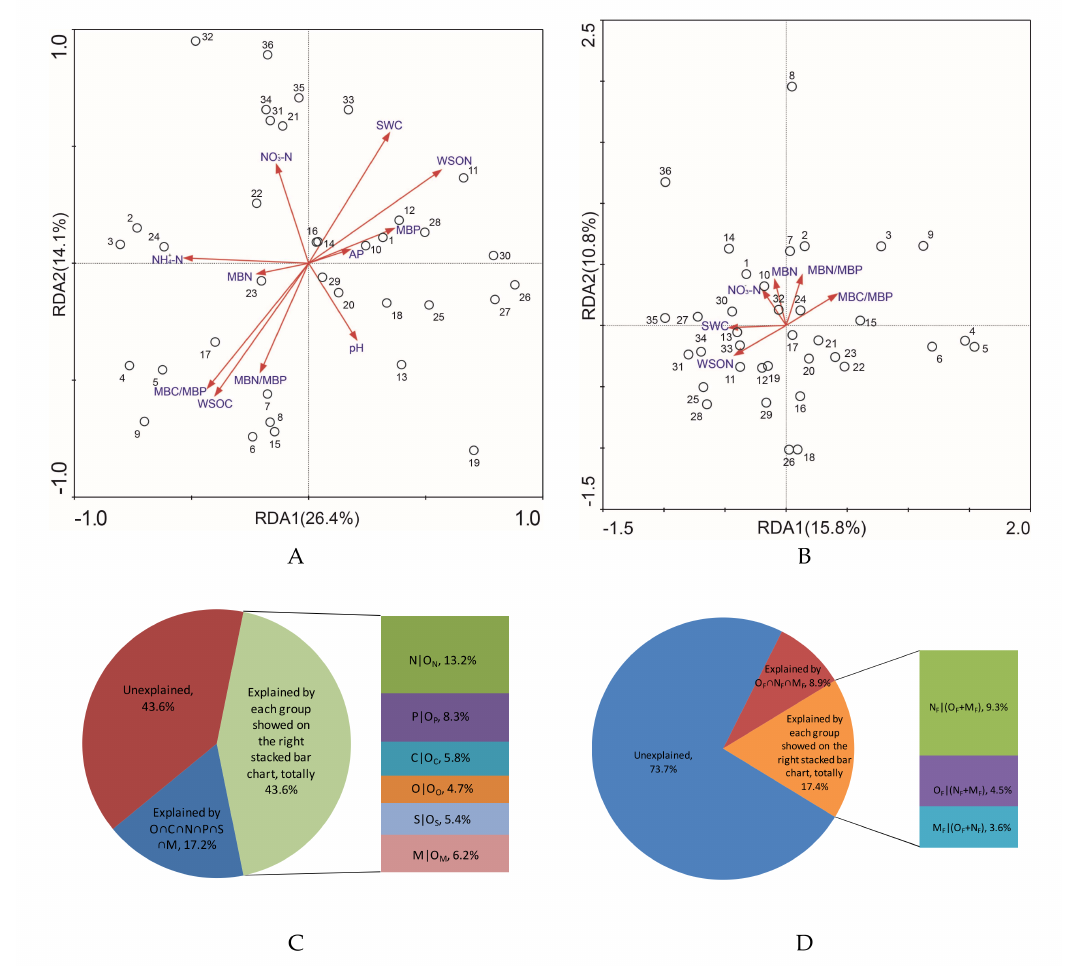
Figure 5. Biplot of redundancy analysis (RDA) of bacterial (( A ), based on OTU datasets of 631 genera) community composition with soil properties selected (11 soil properties selected) based on a variation inflation factor test (VIF) determined in soil samples collected from 36 sample plots in four SND levels, i.e., CK (sample tags from 1 to 9), N30 (sample tags from 10 to 18), N60 (sample tags from 19 to 27) and N90 (sample tags from 28 to 36). RDA of fungal community composition (( B ), based on OTU datasets of 24 genera) with soil properties selected based on correlation and the best multiple regression model. According to the di ff erent groups of soil properties, variance partitioning analysis (VPA, ( C ) for bacteria and ( D ) for fungi) with partial RDA was conducted to identify the proportions of variance